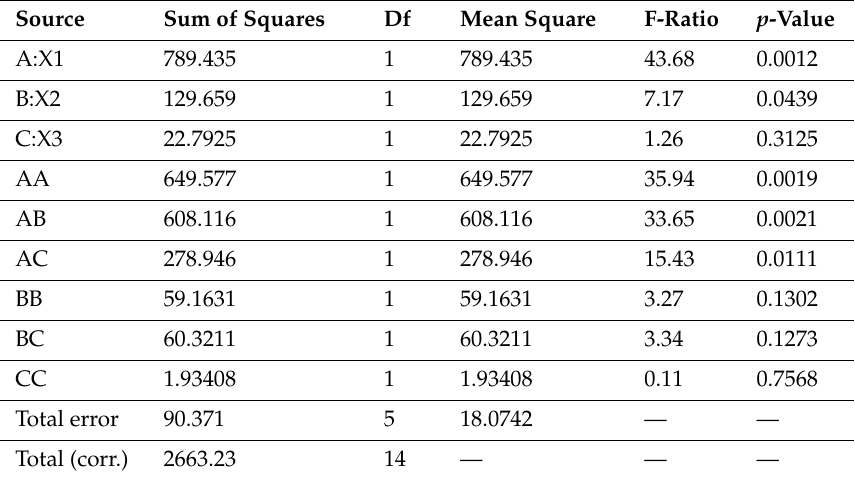
Table 2. Analysis of variance data for globule size.